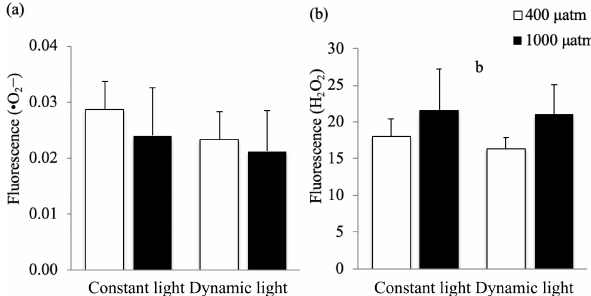
Figure 3. The relative production of (a) oxygen free radicals (cid:113) ( O 2 − ) and (b) hydrogen peroxide (H 2 O 2 ) in Micromonas pusilla under constant light and dynamic light and p CO 2 levels of 400µatm (white) and 1000µatm (black; n = 4; mean ± 1 SD) at time point 1. The letter b indicates a significant difference ( p < 0 . 05) between p CO 2